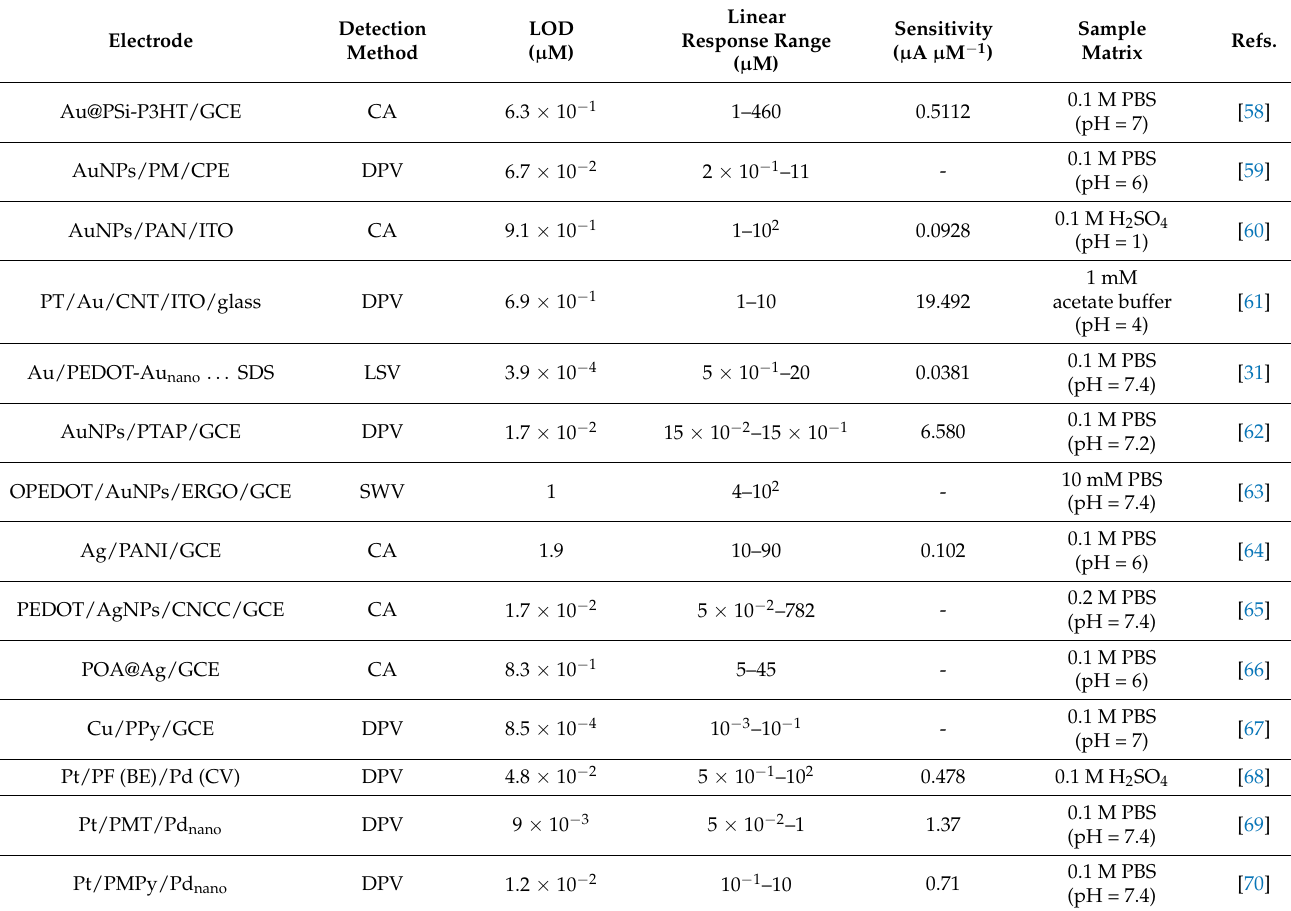
Table 1. Electrochemical sensors for DA detection from recent